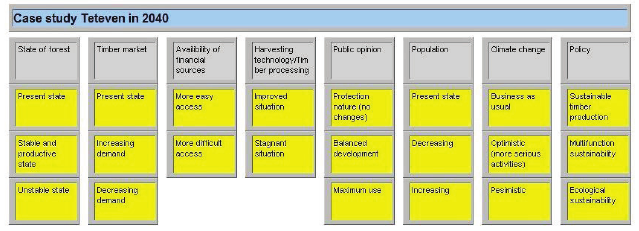
Fig. 5. Overview of the Scenario Space of Teteven